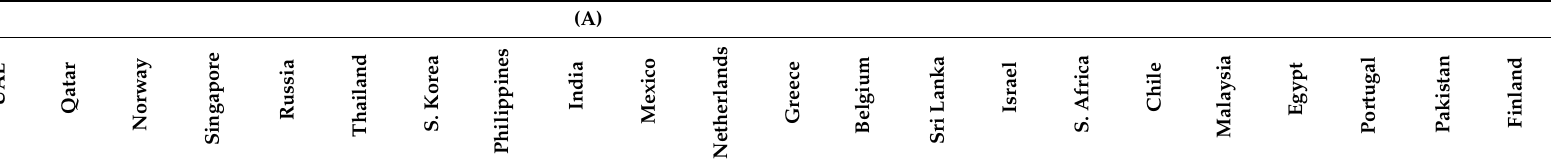
) between countries in the Amihud ) between countries in the highly oil-sensitive Amihud